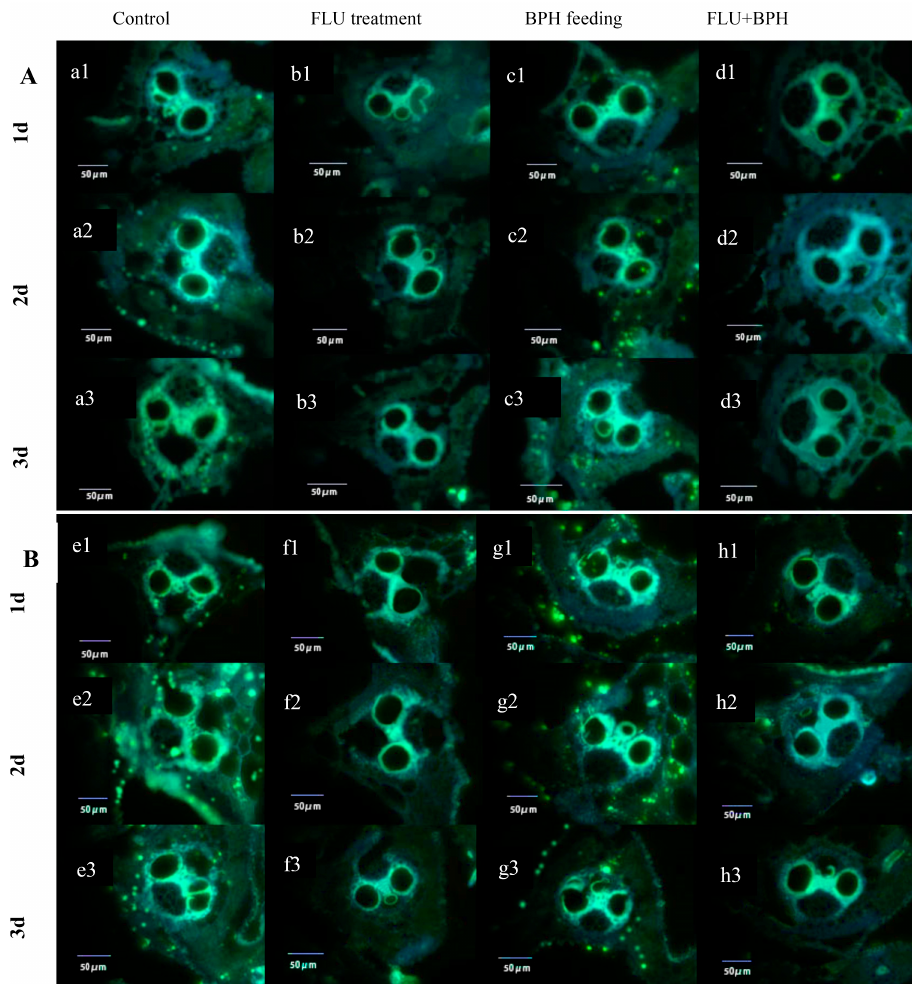
Figure 5. The callose deposition area in TN1 and IR42 rice cultivars after 15 µ mol/L FLU treatment and BPH feeding for 1, 2 and 3 days. The yellowish green fluorescence light spot showed the callose deposition in TN1 ( A ) and IR42 ( B ) rice leaf sheath tissues under a fluorescence upright microscope (Bars = 50 μ m) after FLU treatment and BPH feeding. a1, a2, a3 and e1, e2, e3 (control, without FLU treatment and no BPH feeding); b1, b2, b3 and f1, f2, f3 (15 μ mol/L FLU treatment); c1, c2, c3 and g1, g2, g3 (BPH feeding); d1, d2, d3 and h1, h2, h3 (15 μ mol/L FLU treatment and BPH feeding). Insects 2018 , 9 , x FOR PEER REVIEW